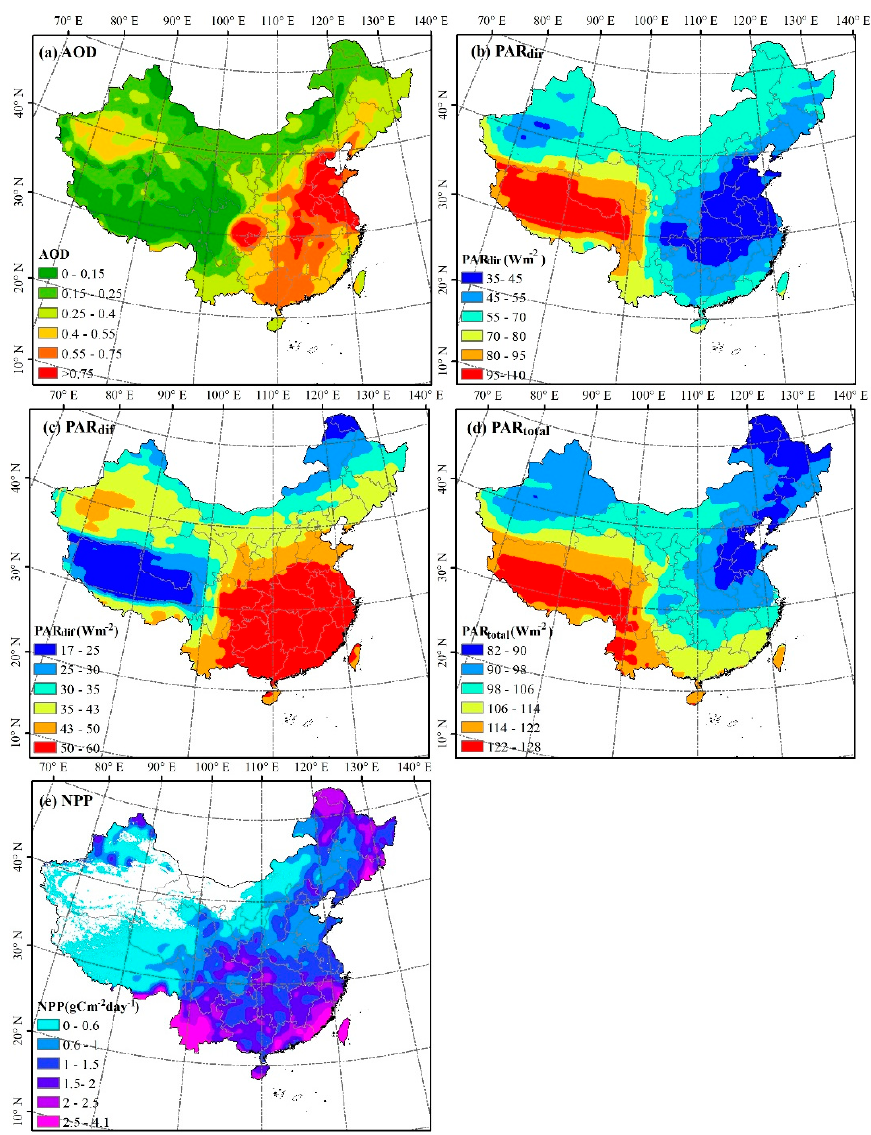
Figure 3. The mean spatial distribution of ( a ) AOD ( b ) PAR dir ( c ) PAR dif ( d ) PAR total and ( e ) NPP over China during 2001–2017.